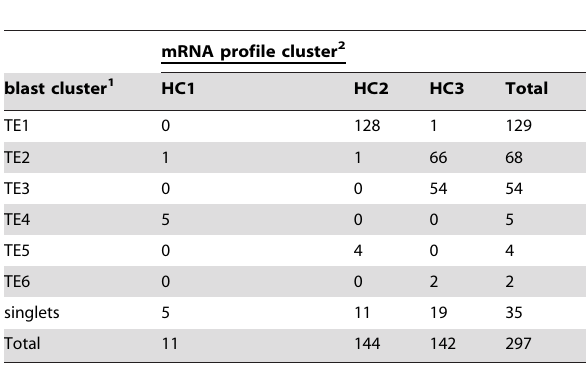
Table 4. Association between blast clusters and mRNA profile